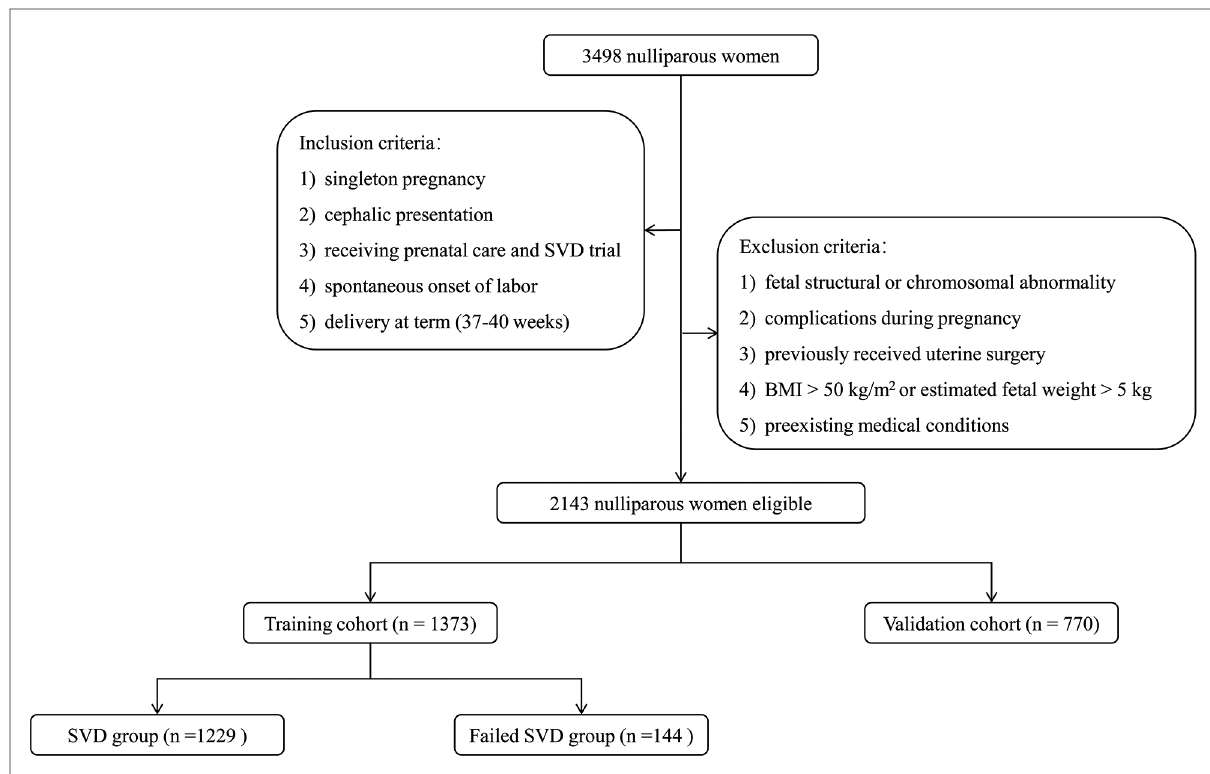
converged in the internal cervix of the ori fi ce (20). Only the last antepartum ultrasound features before delivery were utilized for delivery prediction.